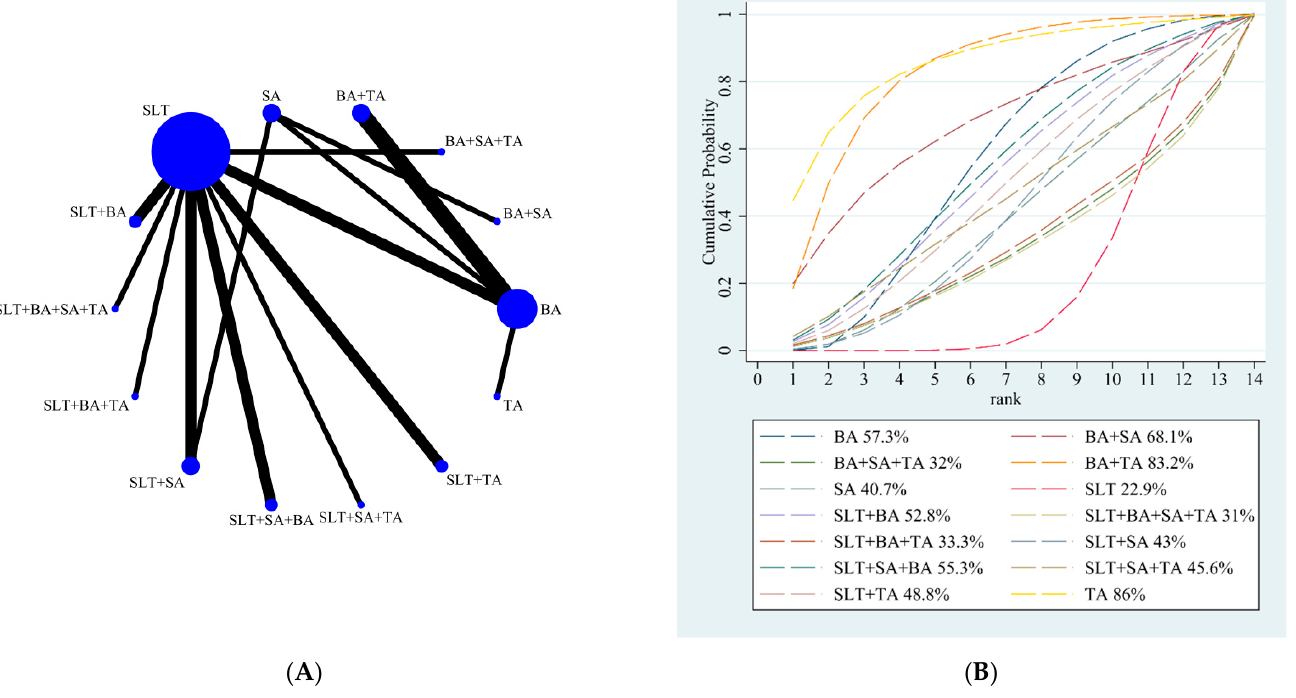
Figure 4. ( A ) NMA figure for the oral expression score. ( B ) SUCRA plot for the oral expression score.